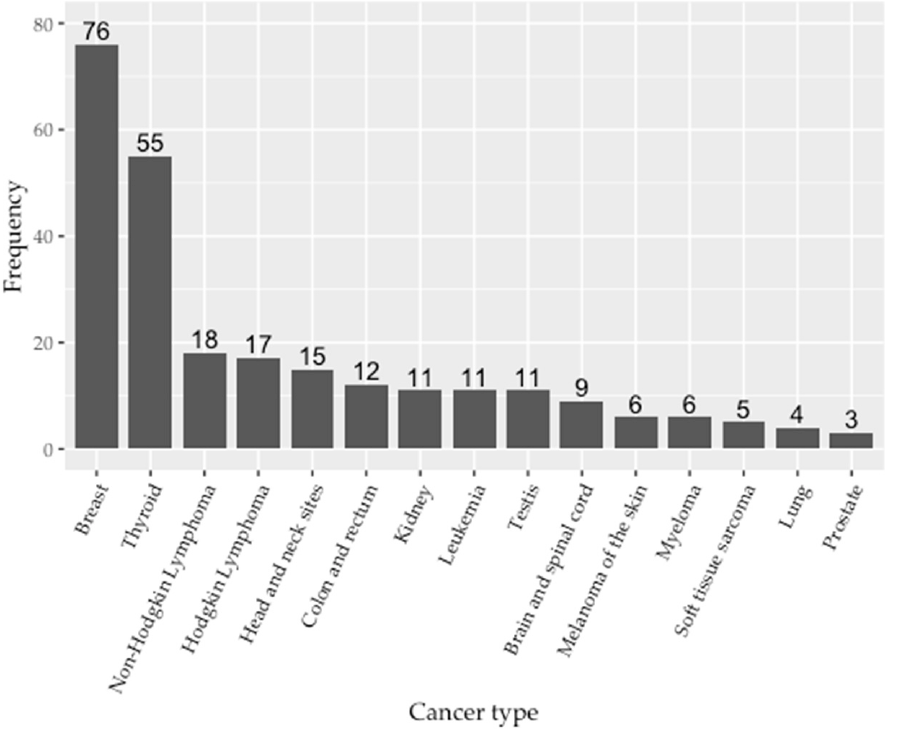
Figure 2. Top 15 cancer diagnoses in EYA included in the WTC EHC cancer analysis. From Table 1, we note that there are only six EYAs in the 0–10 age category. Among them, two were diagnosed with thyroid cancer, two with lymphoma, one with leukemia and one with kidney cancer. We plotted the distribution of the top 15 cancer diagnoses in EYA by those age 20 or younger and those aged 21–30 on 9/11 (Figure 3). Only thirteen cancer sites were identified in the younger age group. The vast majority (81.2%) of cases represented in Figure 3 were identified in the group that was older on 9/11.